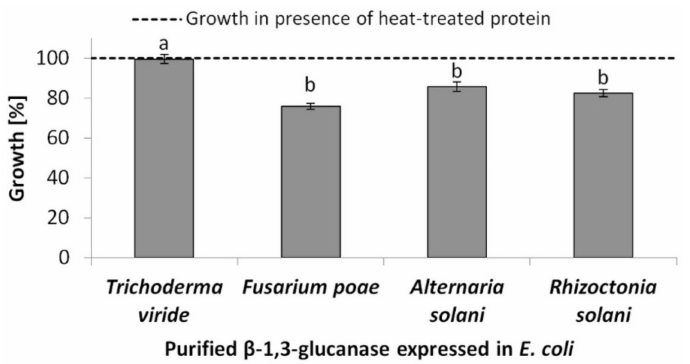
Figure 1. Antifungal effect of 50 µ g of purified rDbGluc1 protein on the growth of filamentous fungi Trichoderma viride , Fusarium poae , Alternaria solani , and Rhizoctonia solani . A difference in absorbance at 595 nm between the start (T 0 ) and final point of co-cultivation (T) compared to the control (heat- treated protein) was used. Values represent the mean of four biological and three technical replicates (Supplementary Table S2). a,b difference at p < 0.05 compared to the control.